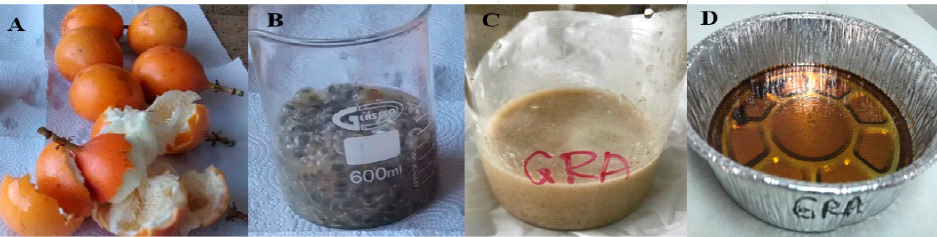
Figure 1. Colombian Passiflora ligularis (granadilla) treatment for polyphenol extraction. ( A ): fresh granadilla, ( B ): pulp and seeds, ( C ): homogenized pulp and seeds, ( D ): granadilla dry polyphenol extract.